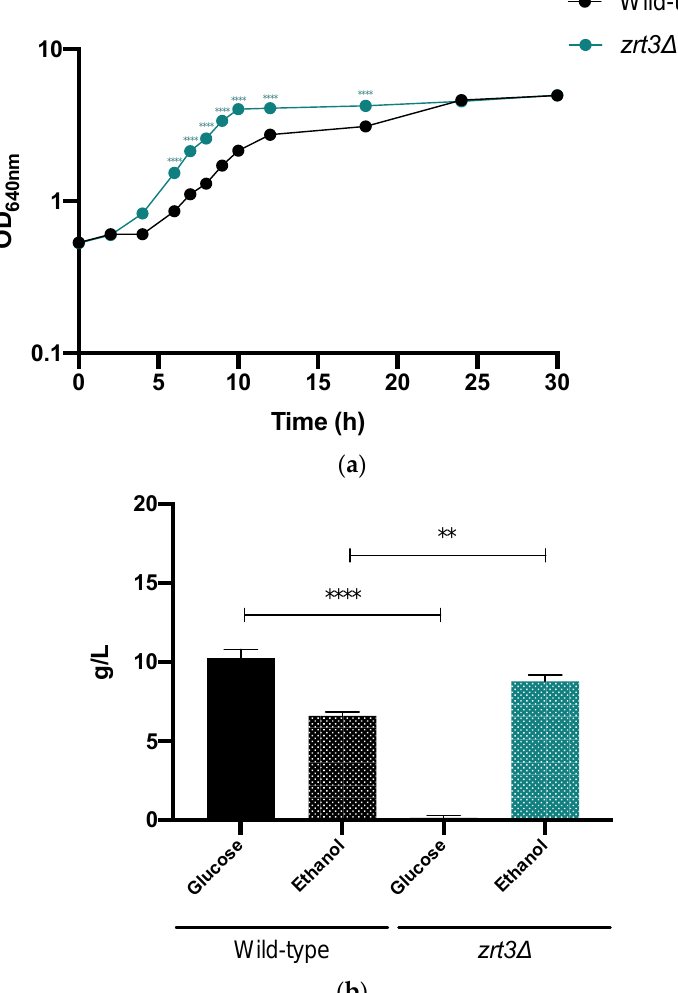
Figure 6. Cell growth, glucose consumption and ethanol production by S. cerevisiae BY4741 wild-type and zrt3 Δ strains on a lignocellulosic hydrolysate. ( a ) Cell growth in a lignocellulosic hydrolysate at pH 4.5 was assessed by measuring optical density along 30 h. ( b ) Glucose and ethanol concentrations were measured 12 h after inoculation, after the zrt3 Δ strain reached stationary phase. Values are the mean ±SEM (n = 3). Statistical analysis was performed by two-way ANOVA. ** p ˂ 0.01, **** p ˂ 0.0001 in comparison with the indicated conditions.